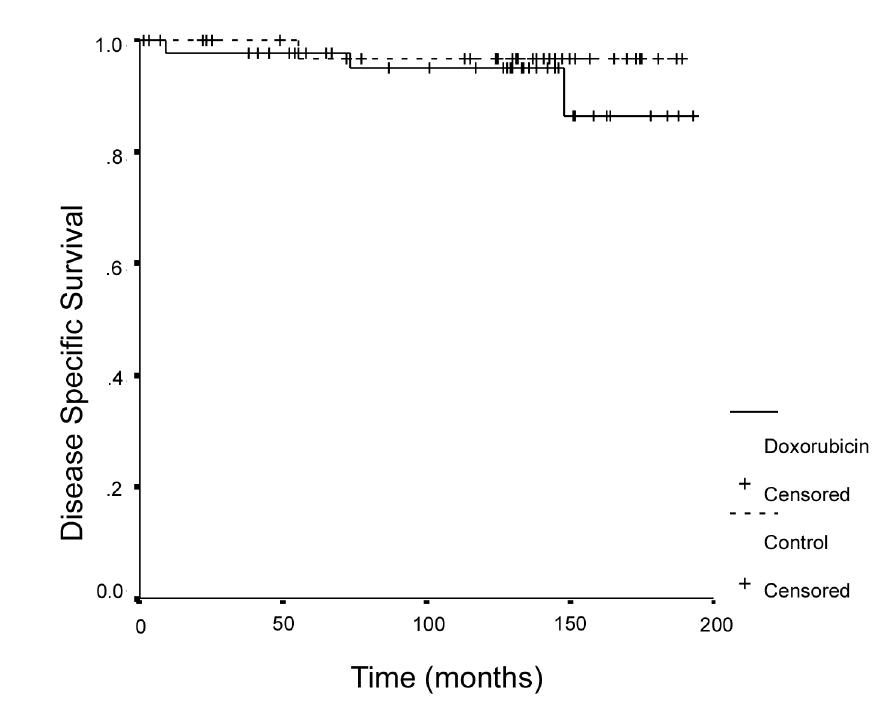
Figure 3 – Disease specific survival curves of doxorubicin group (solid line) and control group (dotted line). Log rank test, p =